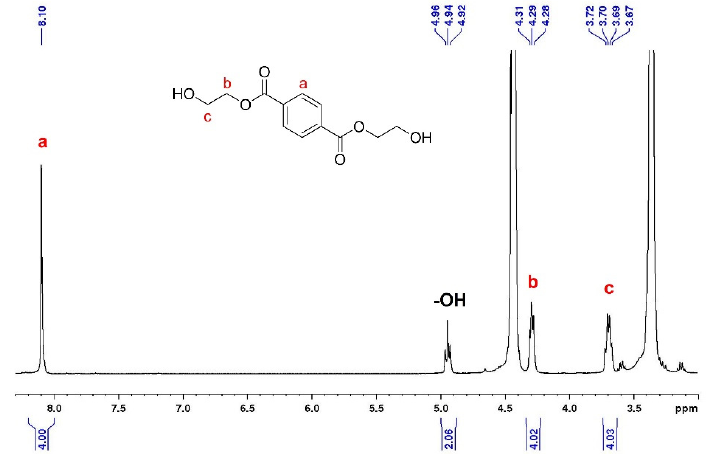
Figure 4. 1 H NMR (CDCl 3 , 400 MHz, 25 °C) BHET obtained via crystallization from cold water.